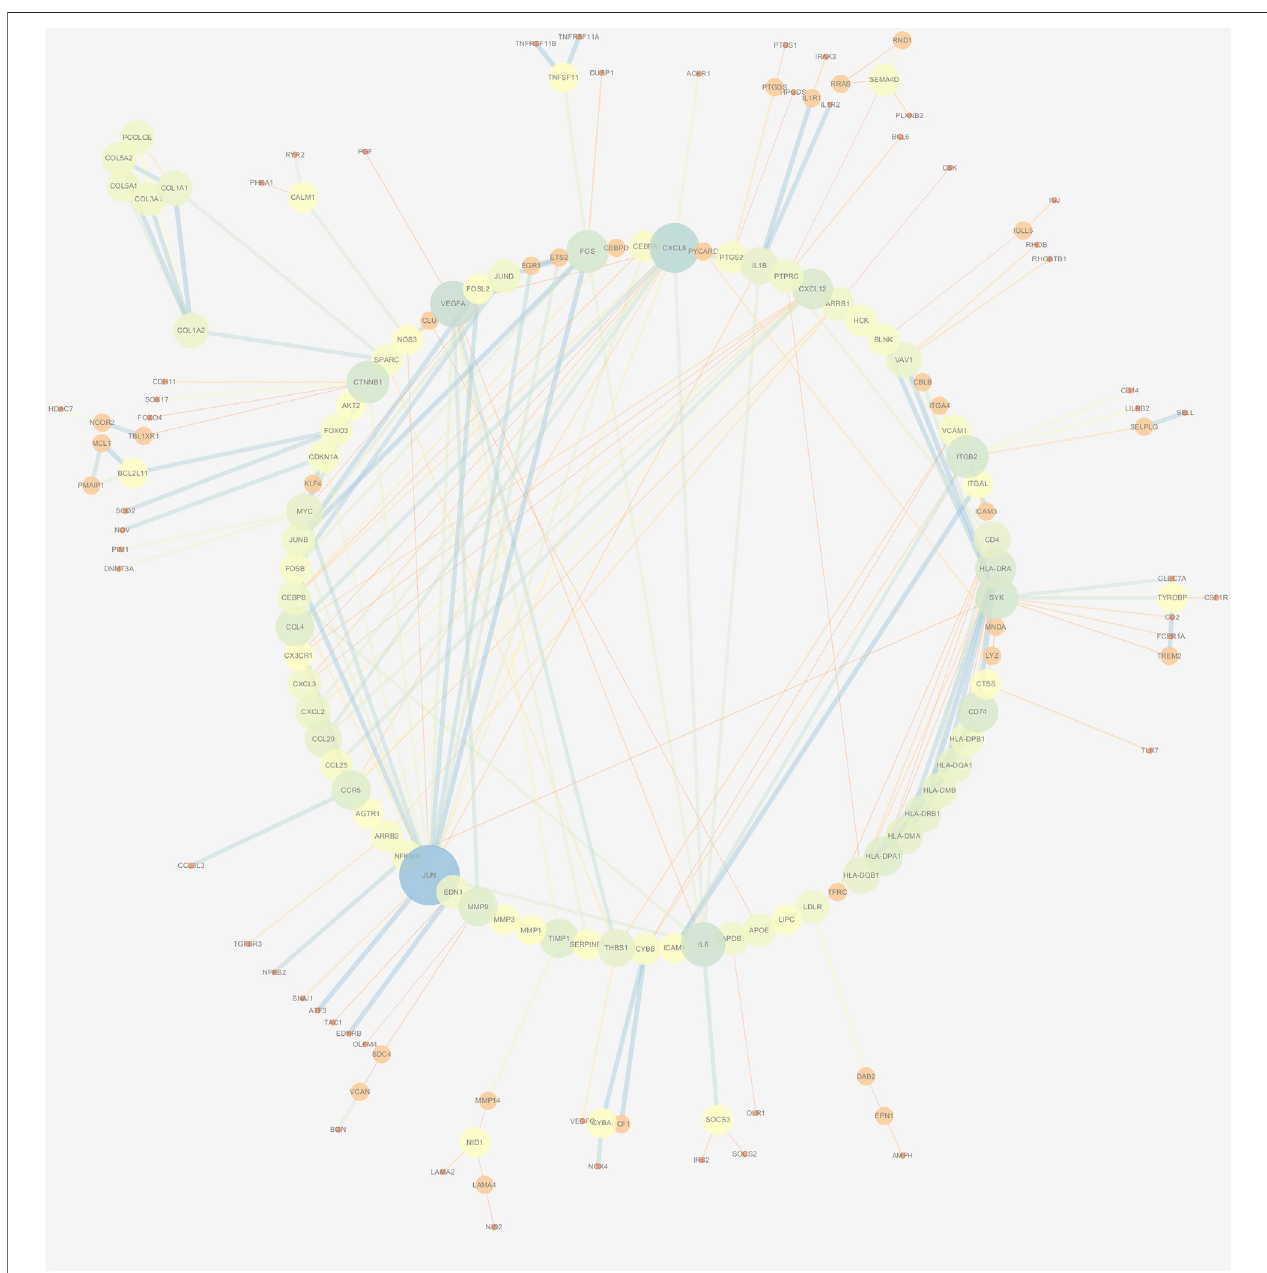
FIGURE 5 | PPI network construction of DEGs. Low value of the combined score to small circle, circle with bright colors, and line with small sizes.